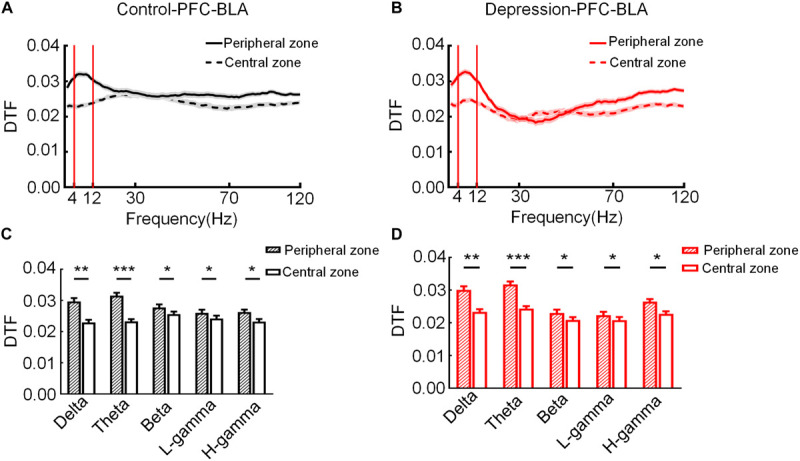
Direct transfer function (DTF) at different frequencies of the mPFC-BLA network in the peripheral and central zone. (A) DTF in the peripheral and central zone of the control group. (B) DTF in the peripheral and central zone of the depression group. The bandwidth calculated for DTF ranged from 1 to 120 Hz. (C) DTF of the control group in different frequency bands in the peripheral and central zone. (D) DTF of the depression group in different frequency bands in the peripheral and central zone. Error bars indicate SEM. Paired sample t-test, *p < 0.05, **p < 0.01, ***p < 0.001.